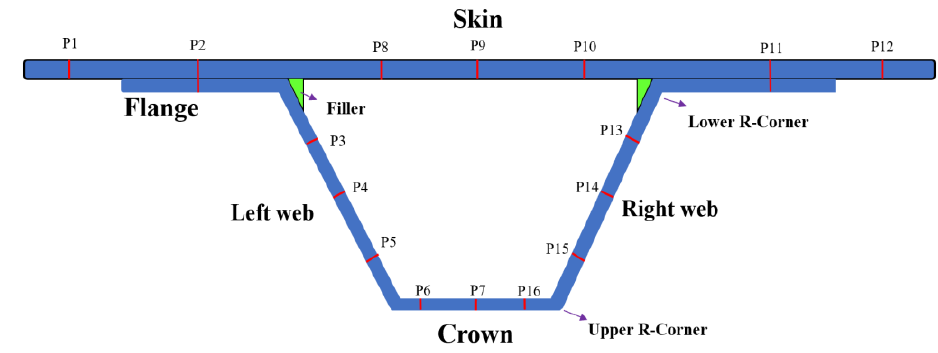
Figure 5. Thickness measurement positions of stringer-stiffened panel.